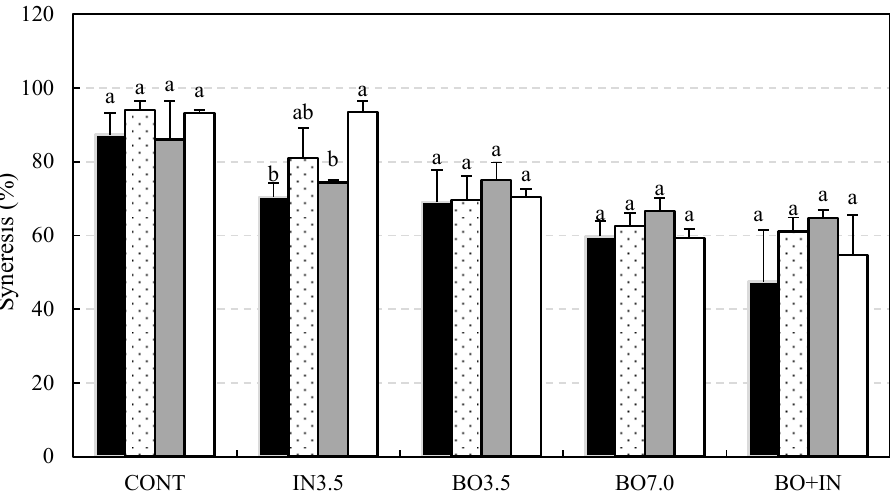
Figure 2. Syneresis (%) of kefir-fermented soymilk supplemented with inulin and/or bocai ú va powder-pulp at 1 (black bar), 6 (dots), 11 (gray), and 16 (white) days of shelf storage. CONT, without adding ingredients; IN3.5, with the addition of 3.5% inulin ( m / v ); BO3.5, with the addition of 3.5% bocai ú va powder-pulp ( m / v ); BO7.0, with the addition of 7.0% bocai ú va powder-pulp ( m / v ); and BO + IN, addition of 3.5% inulin + 3.5% bocai ú va powder-pulp. Different letters indicate a statistical difference between the fermented beverages during the shelf life by the Tukey test ( p < 0.05).